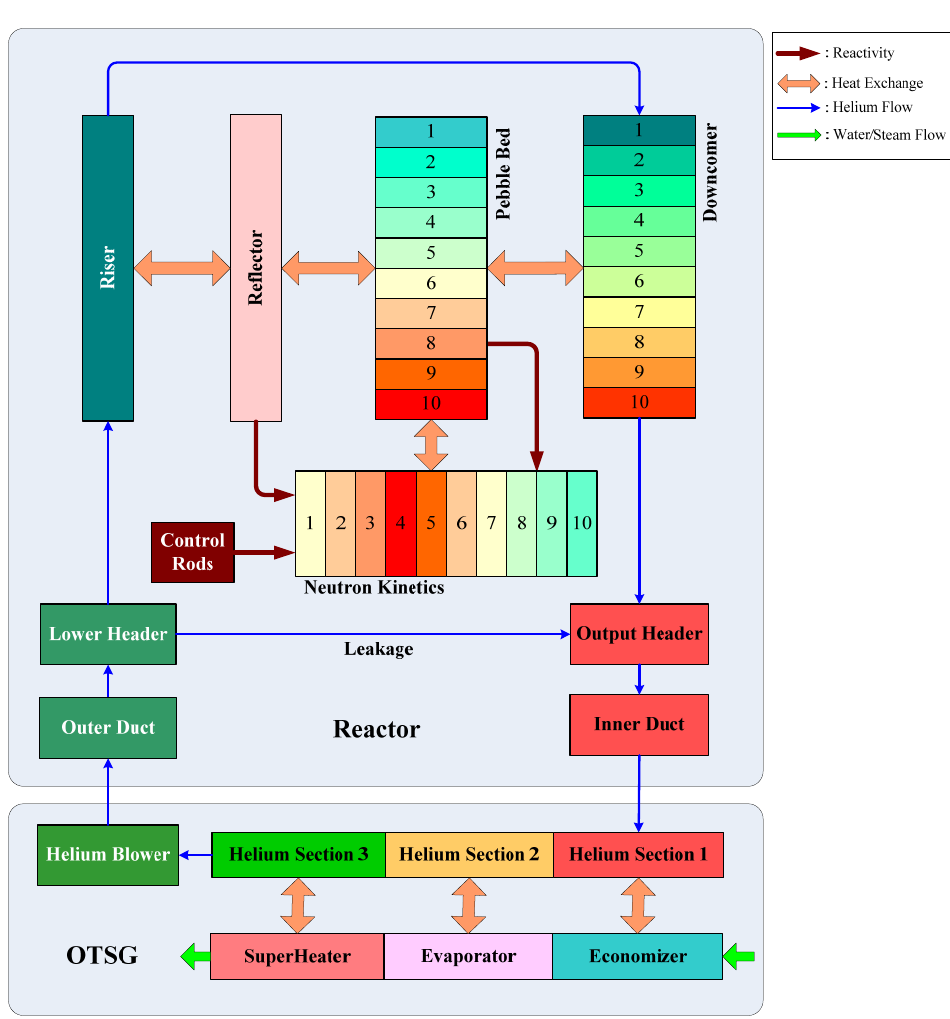
Figure 2. Schematic view of the dynamic model of the